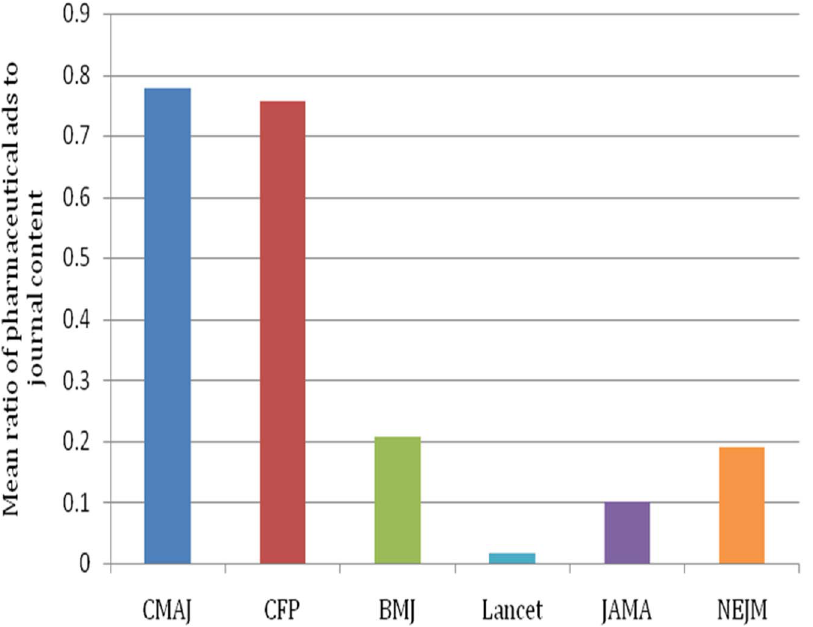
Figure 2. The mean ratio of the number of pages of pharmaceutical advertising to number of pages of journal content, 2007 to 2012.